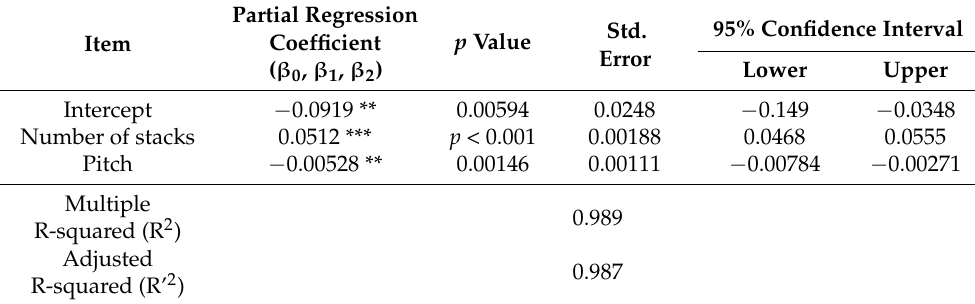
Table 8. Multiple regression analysis results using progressive crushing mode results (CFL).